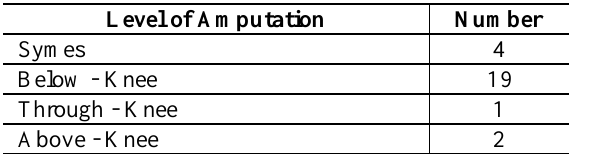
Table I : Level of Initial Amputation